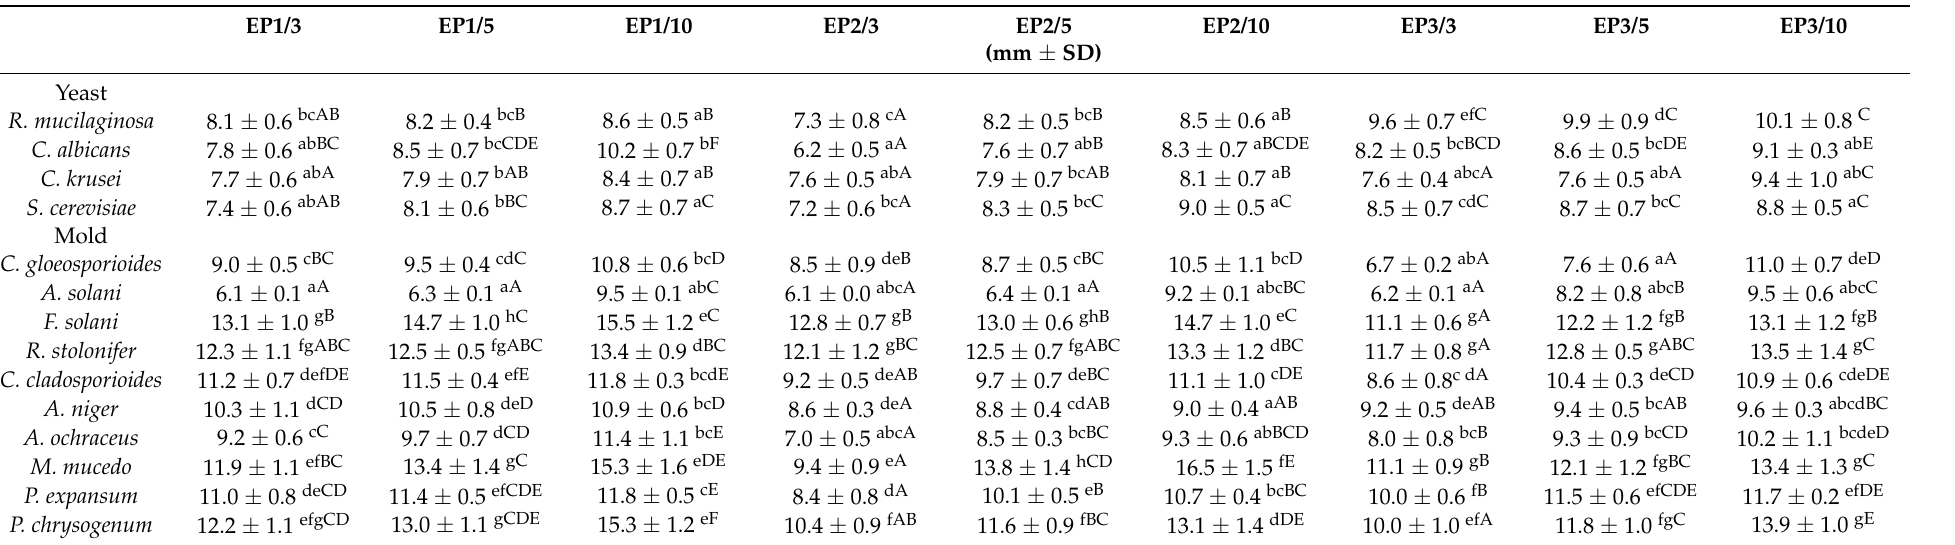
Table 3. Diameters of zones of growth inhibition (DZGI) of fungal strains by pullulan films containing propolis